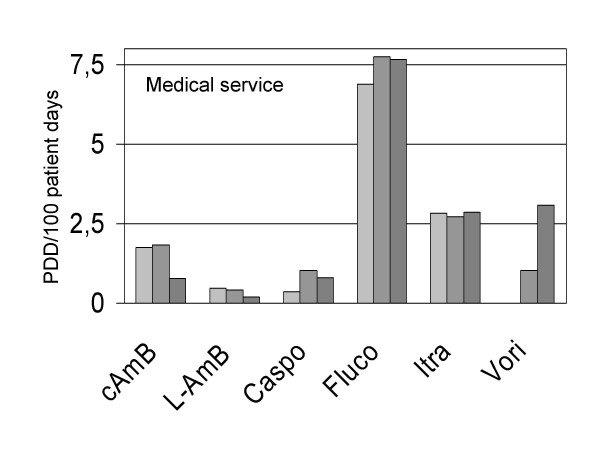
Use density for different antifungal drugs in the medical service of five university hospitals. Data are yearly means for 2001, 2002 and 2003. cAmB, conventional amphotericin B; L-AmB, liposomal amphotericin B; Caspo, caspofungin; Fluco, fluconazole; Itra, itraconazole; Vori, voriconazole.